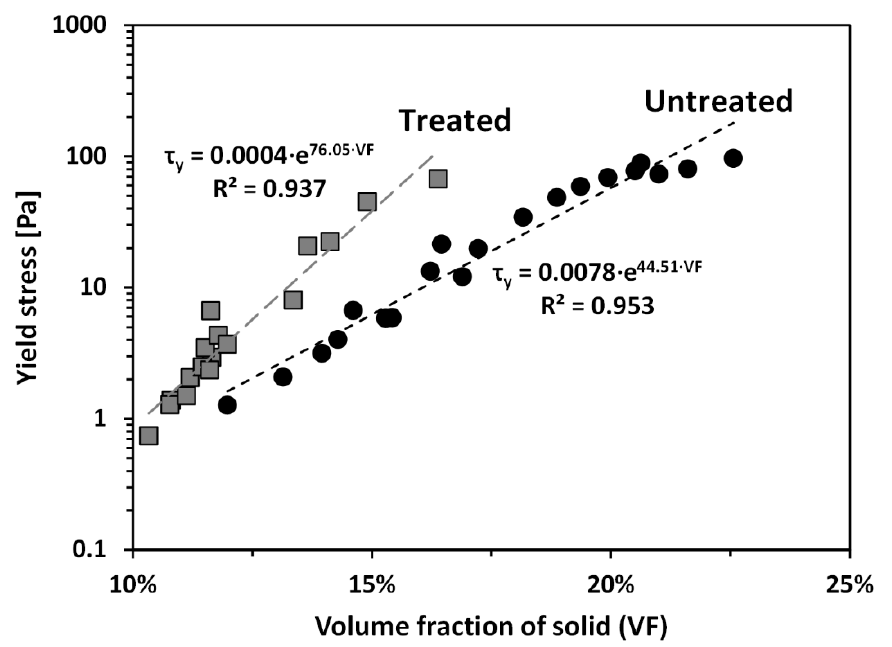
Figure 4. Yield stresses of untreated and treated clays as a function of volume fraction of solid ( VF ).